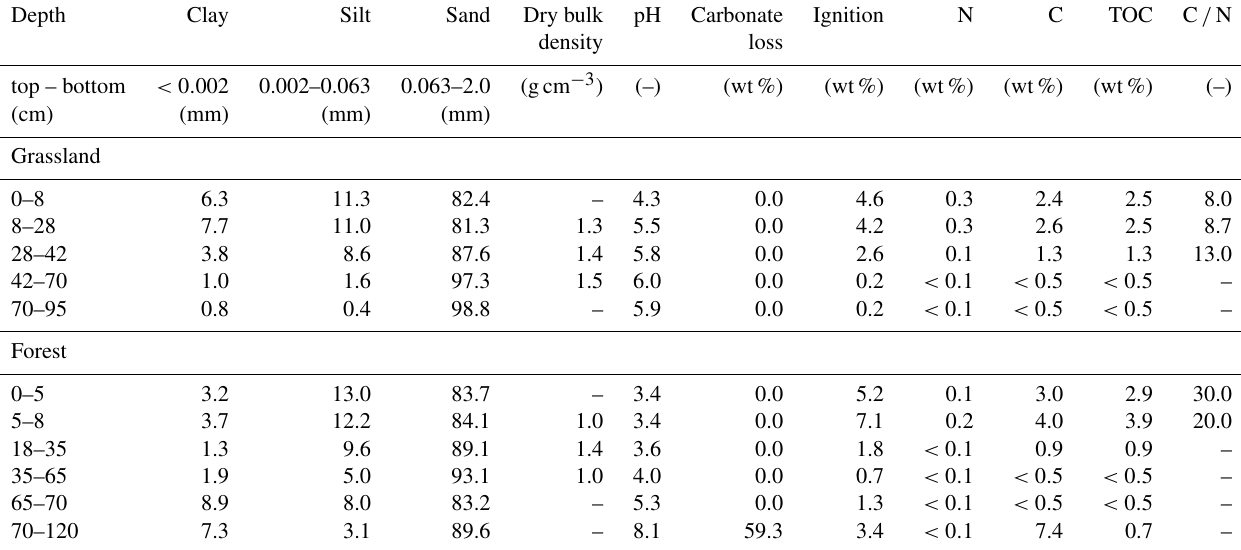
Table 1. Soil characteristics of the grassland and forest plot sites (sampled on 20 March